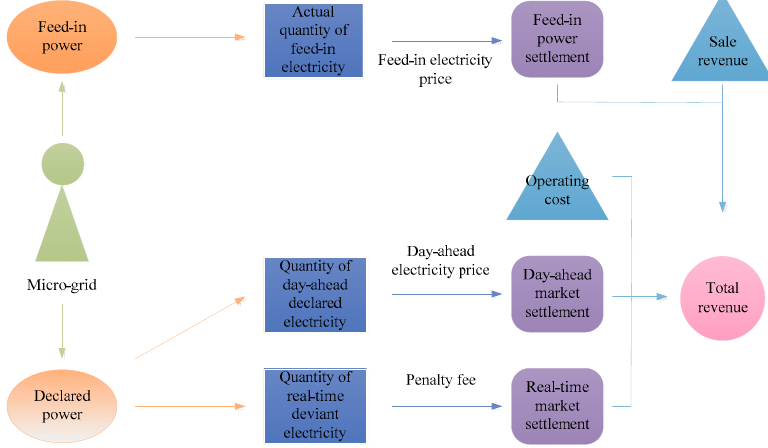
Figure 2. The flow chart of the microgrid participating in the spot market.